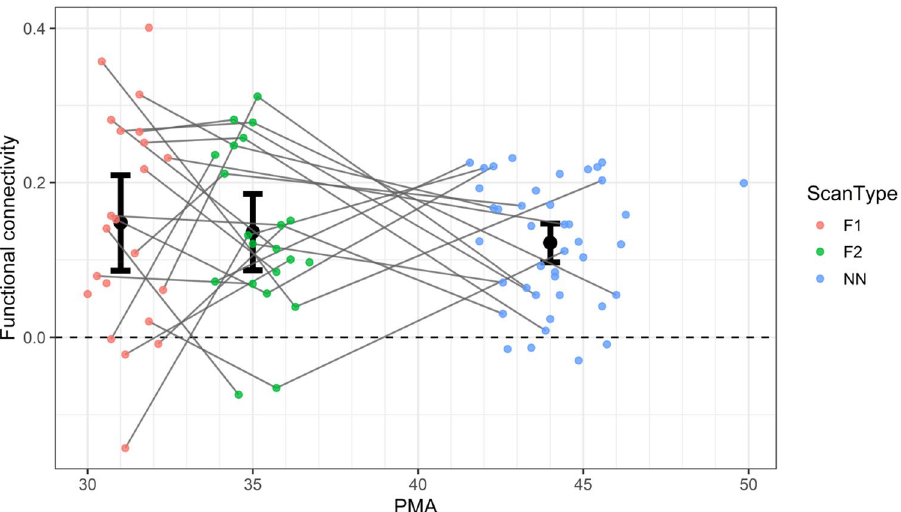
Figure 3. Average (+ /− 2 standard errors) left anterior insula–left amygdala functional connectivity in a sample with low likelihood of developing autism at 31 (F1, red), 35 (F2, green), and 44 (NN, blue) postmenstrual